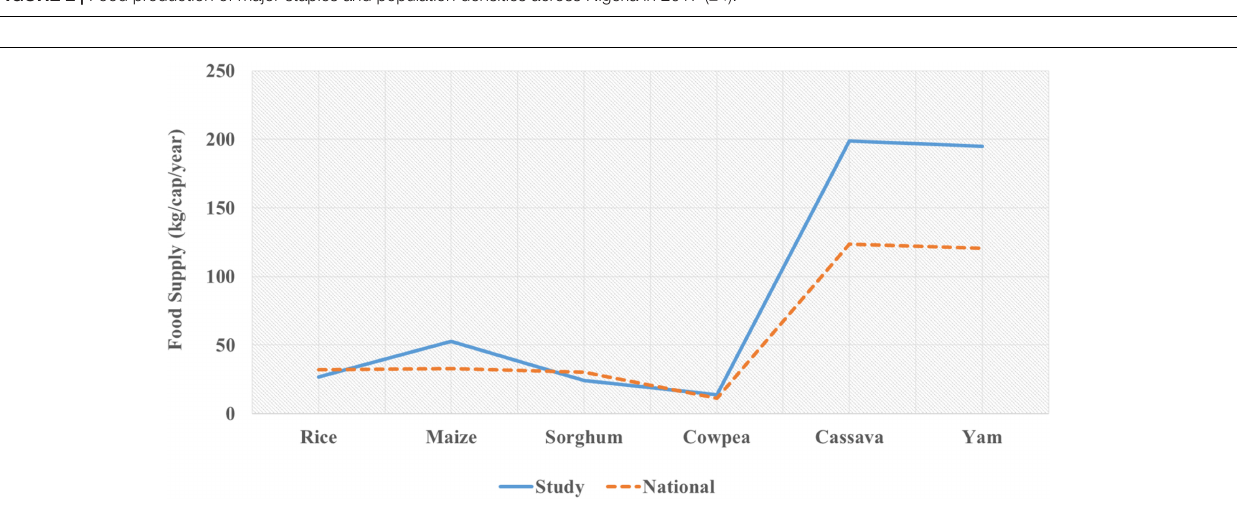
FIGURE 2 | Food production of major staples and population densities across Nigeria in 2017 (24).